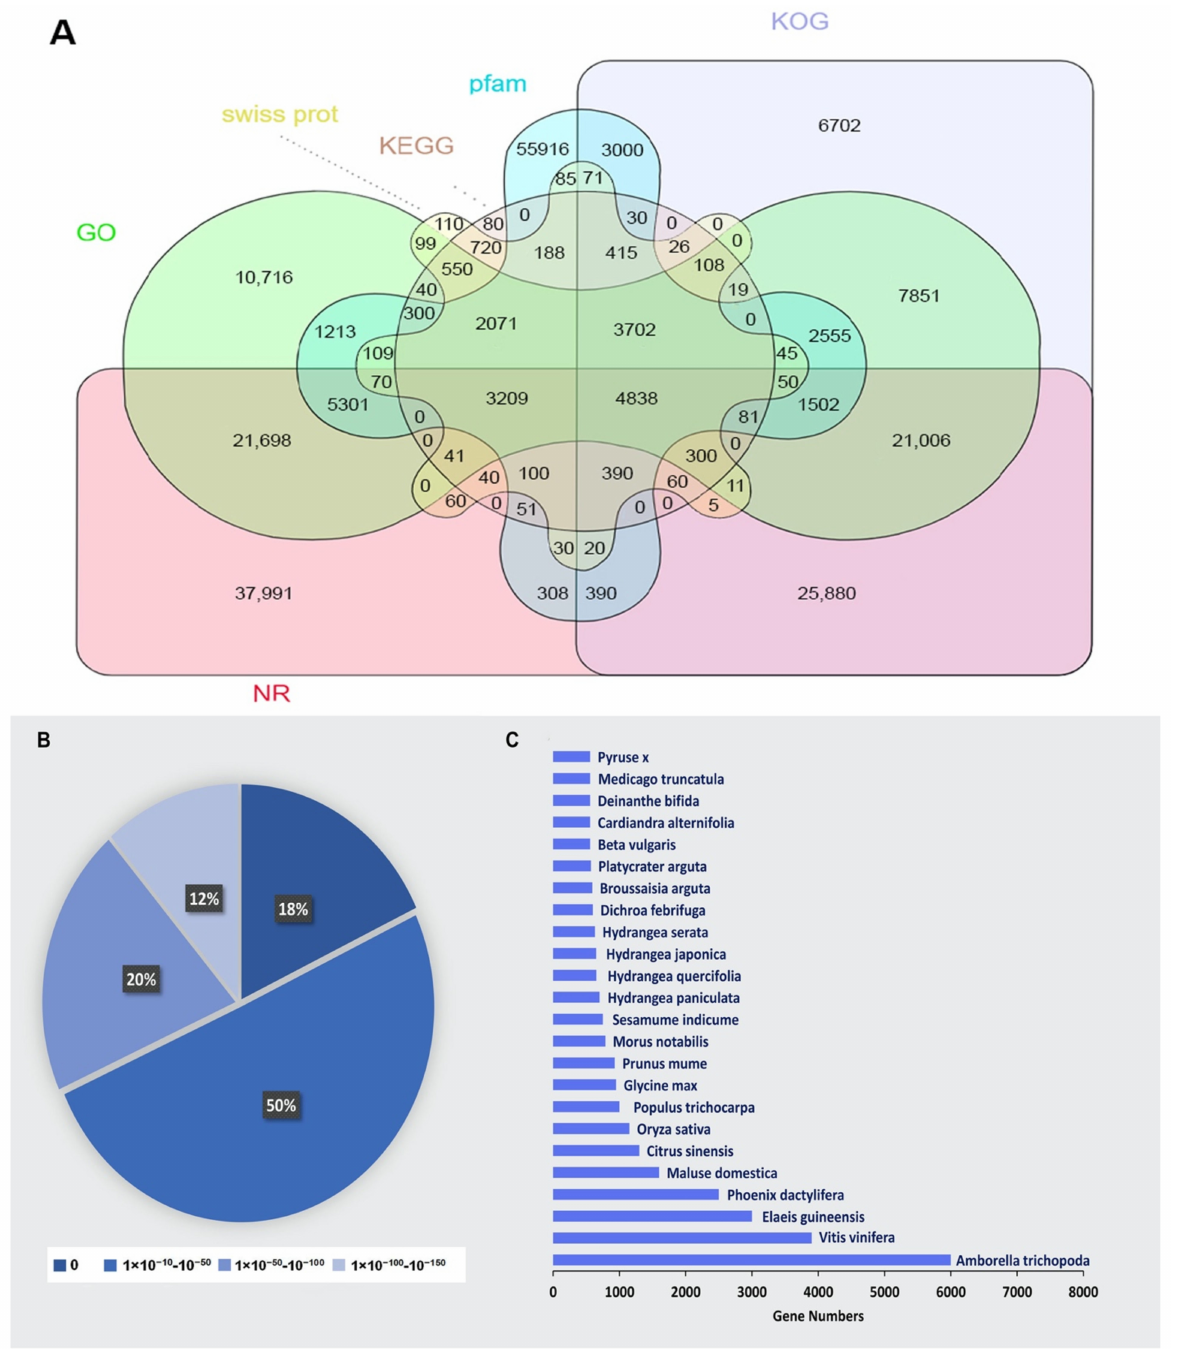
Figure 2. Characteristics of homology search of Hydrangea macrophylla unigenes. ( A ): Venn diagram of the number of unigenes annotated by BLASTx with an E-value threshold of 10 − 5 against six protein databases. ( B ): E-value distribution of the top BLASTx hits against the NR database for each unigene. ( C ): Number and percentage of unigenes matching the top 24 species using BLASTx in the NR